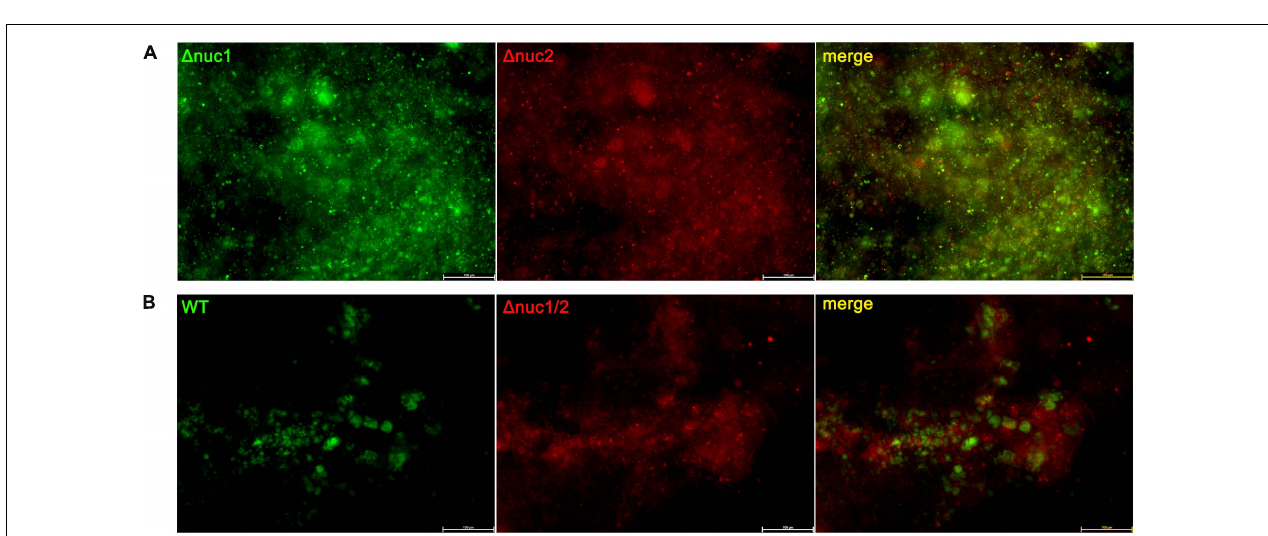
FIGURE 3 | Bacterial burden in an exogenous IAI mouse model. CFU for peri-implant tissue and biofilms on implant was determined 7 days after infection. (A) Bacterial count for peri-implant tissues and representative photos (B) . (C) Bacterial count for biofilms on implant and representative photos (D) . Statistical significance was calculated using ANOVA with Dunnett multiple column comparisons. n = 10/group. * p < 0.05 vs. WT.